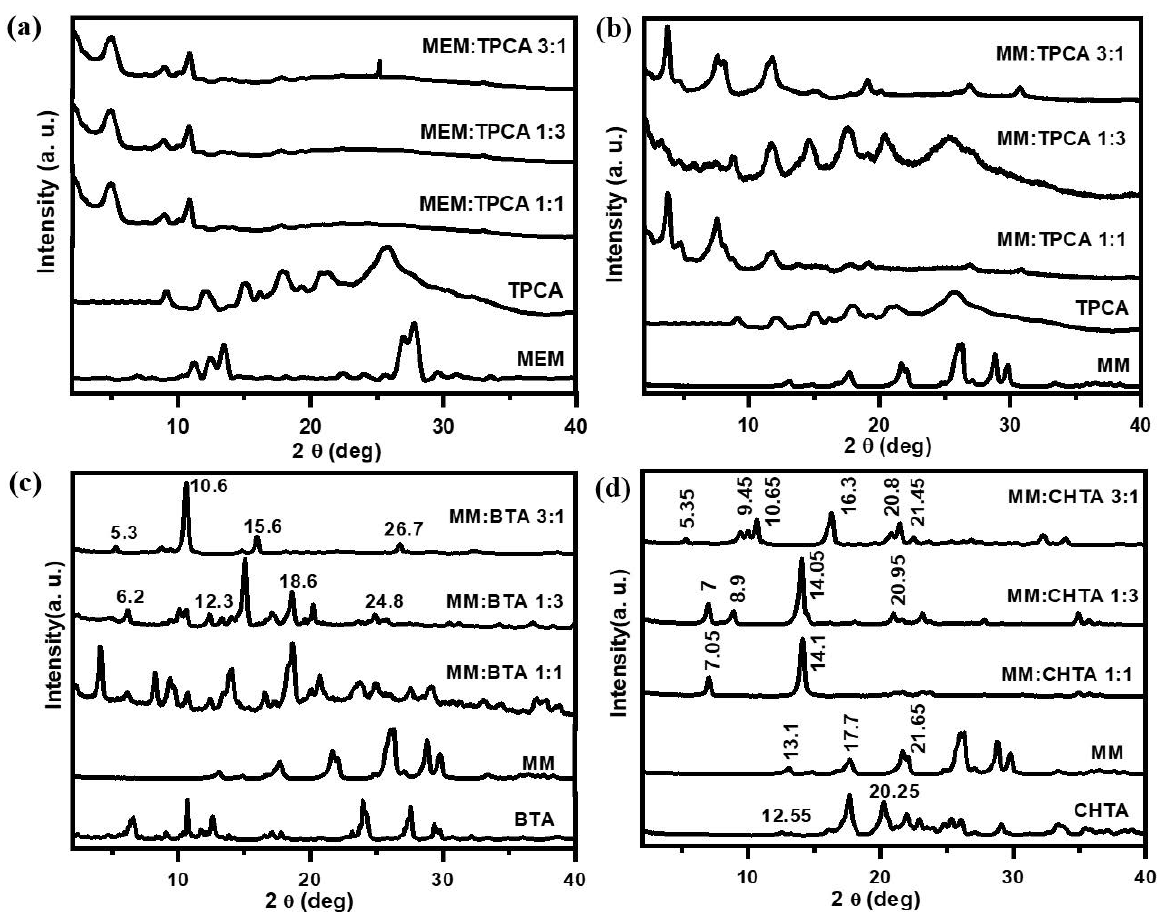
Figure 5. XRD patterns of ( a ) MEM–TPCA, ( b ) MM–TPCA, ( c ) MM–BTA and ( d ) MM–CHTA dried network prepared from the respective hydrogel at three different molar ratios and individual moieties (MM, MEM, TPCA, BTA and